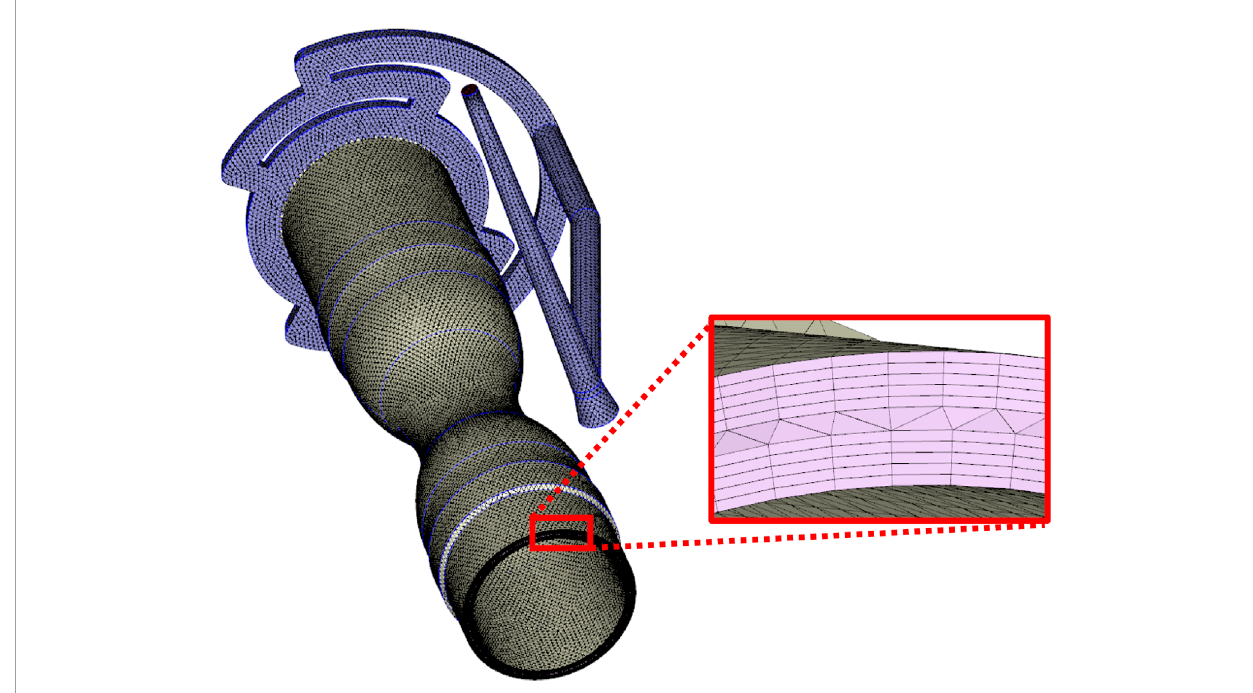
FIGURE 4 Detail of the meshed Venturi tube geometry (blue: runner, yellow: part).